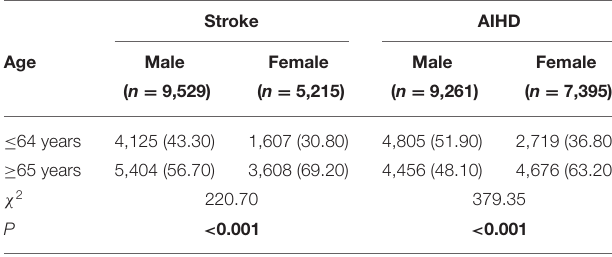
TABLE 1 | Descriptive characteristics of AIHD and stroke hospital admissions in Xi’an by age and sex, n